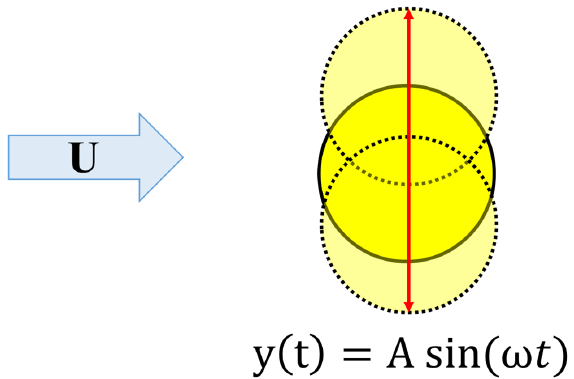
Figure 6. Forced oscillations of circular cylinder.